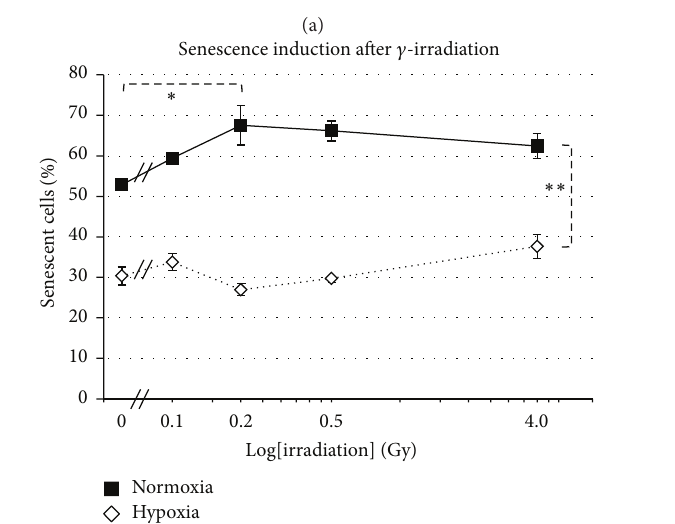
Figure 2: Effects of oxygen levels on sensitivity of p53 wild-type mMSCs for radiation-induced senescence. (a) Green SA 𝛽 -gal positive mMSCs in sham-irradiated (0Gy) hypoxic (upper left) and in normoxic cultures (upper right) and 7 days after exposure to 4 Gy 𝛾 -irradiation (hypoxia, lower left, and normoxia, lower right). (b) Percentage of cells undergoing senescence in hypoxic and normoxic conditions after increasing doses of 𝛾 -irradiation depicted as mean values ± standard error of the mean (4 biological replicates), radiation dose on logarithmic